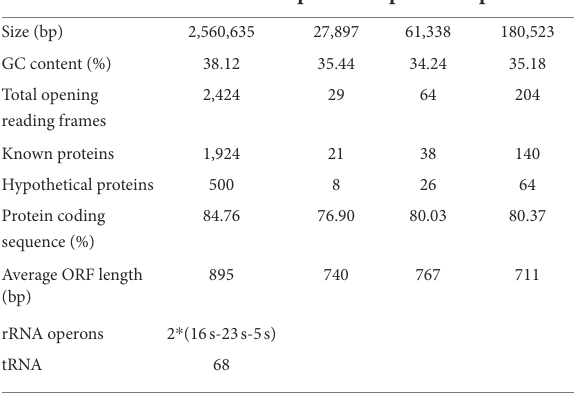
TABLE 3 General features of the genome of E. faecium